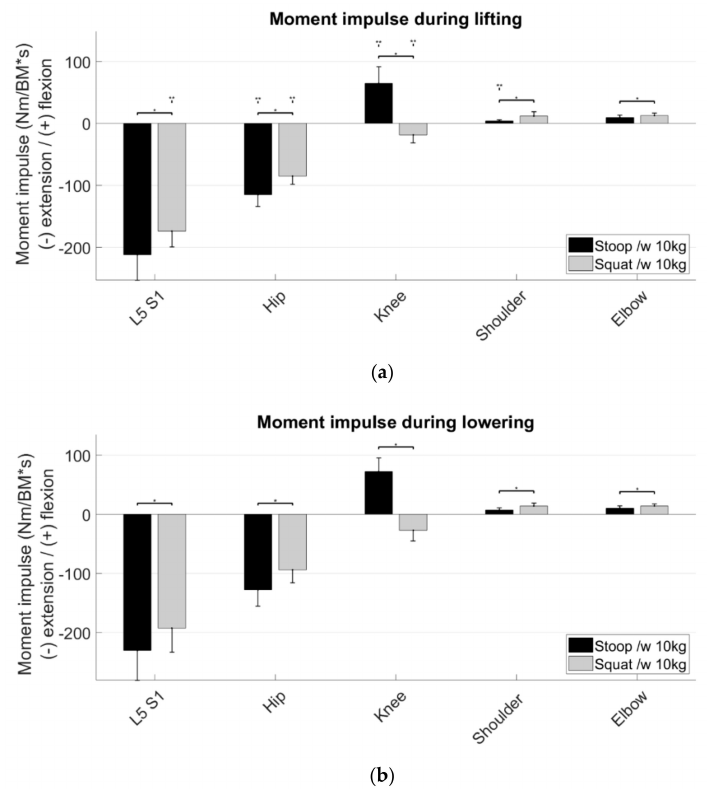
Figure A3. Moment impulse normalized to body mass during the two di ff erent lifting techniques (stoop and squat) with the 10 kg box. Statistical significant di ff erences ( α < 0.05) between the handling phases are indicated with three dots, and statistical meaningful di ff erences between techniques and loads are indicated with one dot. Error bars indicate standard deviations. ( a ) Moment impulse during the lifting phase in the five di ff erent joints (L5S1, hip, knee, shoulder and elbow); ( b ) moment impulse during the lowering phase in the five di ff erent